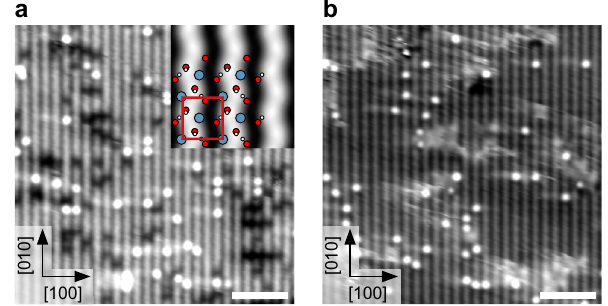
Fig. 7 The (1 × 1) OH overlayer and molecular water. a STM image after dosing 0.4 L on the almost fully-developed (1 × 3) overlayer in Fig. 7c. The sample is almost completely covered by undulating, bright lines in [010] direction, showing only a few gaps, where the (1 × 3) structure is still visible. The single, bright features are unidenti fi ed adsorbates (approx. 0.03 ML) from the residual gas. The inset shows the DFT model and TH simulation of the (1 × 1) OH overlayer, i.e., the full monolayer. Both equivalent adsorption sites (B1O1 and B2O2) in the unit cell are occupied, i.e., all surface oxygens are hydroxylated. b STM image after exposing the sample in panel a to 0.75 L water. The gaps in the undulating bright hydroxyl lines have closed. The diffuse, white patches are assigned to molecular water (see Fig. 2). STM parameters: T sample = 78 K, V sample = − 0.8 V, I tunnel = 0.1 nA; fast scan direction is 18° clockwise from horizontal . All scale bars correspond to 3